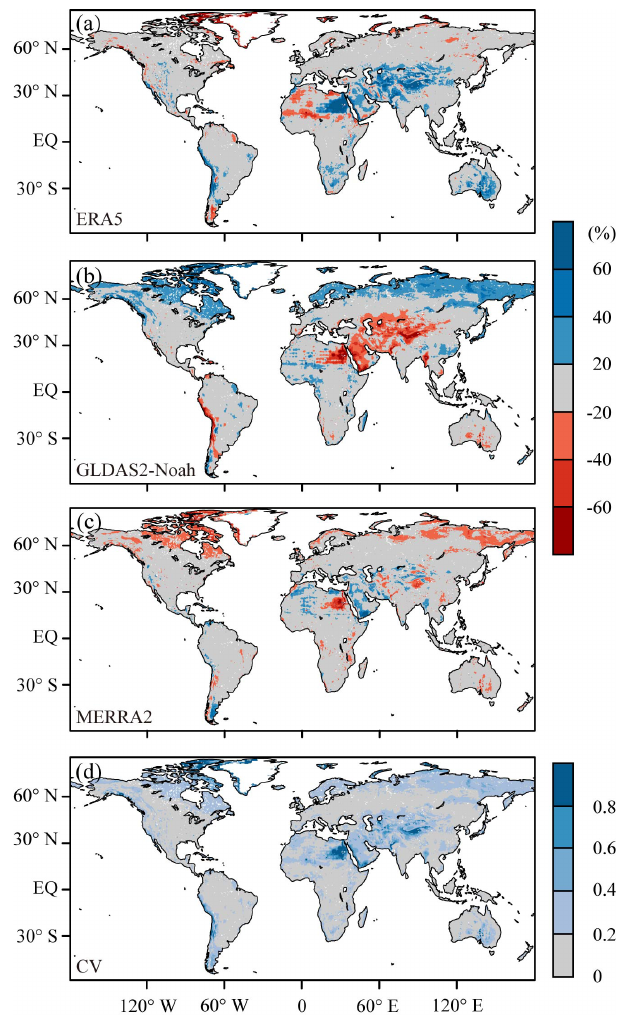
Figure 2. (a–c) The percentage of the difference between ERA5, GLDAS2–Noah and MERRA-2 and average of the three datasets. (d) Variable coefficient of the three